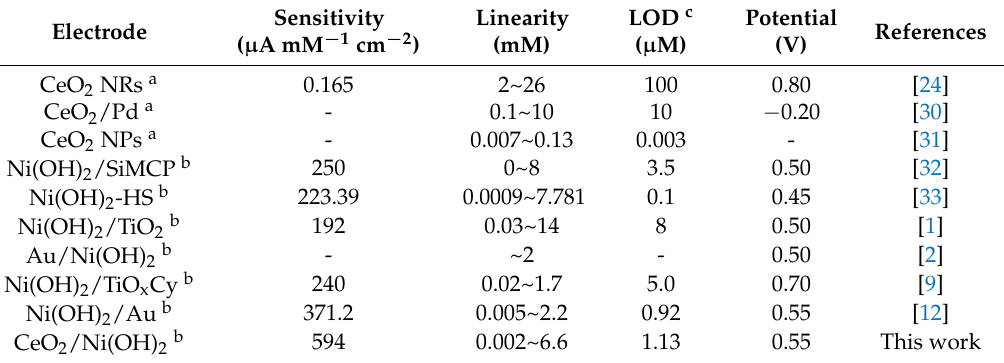
Figure 9. Amperometric response of CeO 2 /Ni(OH) 2 /CPE measured at 0.55 V in 0.1 M NaOH solution with successive addition of glucose. Inset is the plot of current response with glucose concentration. Table 1. Comparison of performance obtained from different glucose biosensors.